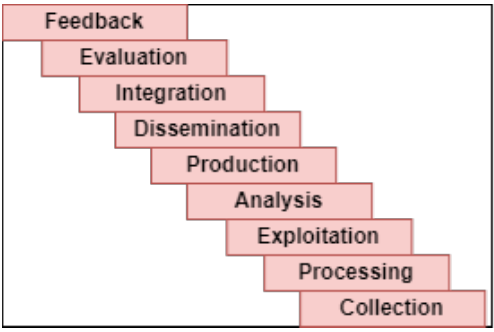
Figure 9. CTI Frame of